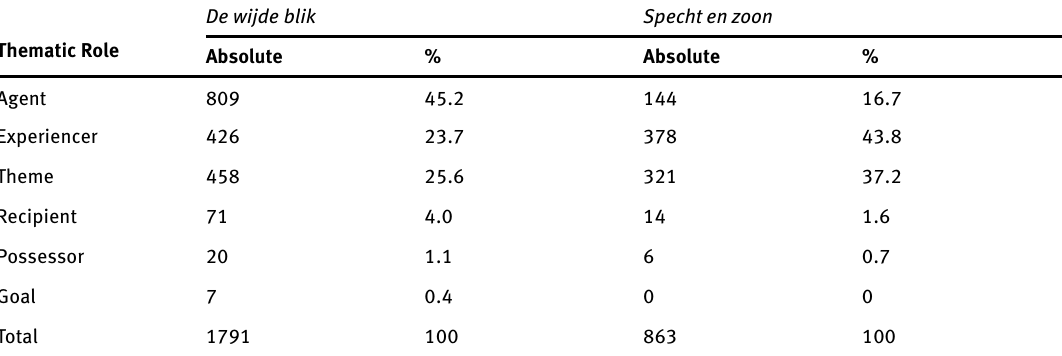
Table 2: Thematic roles associated with the first person narrator by